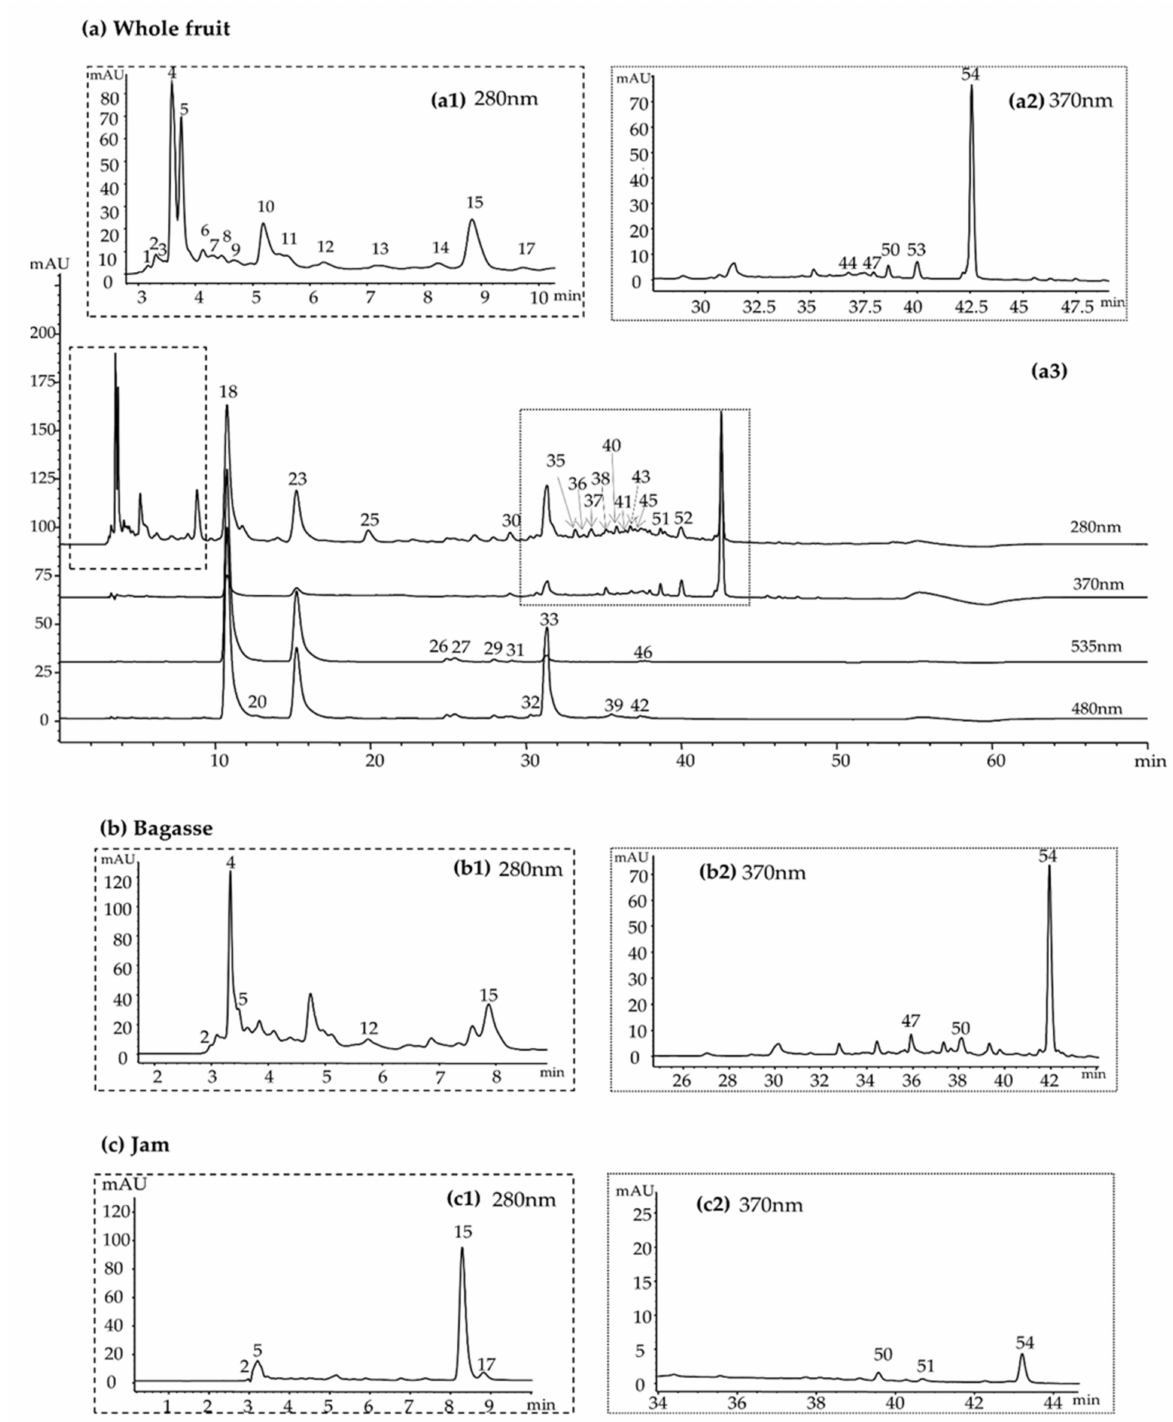
Figure 3. HPLC-DAD chromatogram of betalains and phenolic compounds in Opuntia stricta var. Dillenii from ( a ) whole fruit at 280 nm (zoom chromatogram 0–10 min, a1 ), 370 nm (zoom chromatogram 25.5–50 min, a2 ), and all chromatograms with UV-vis detection: 280, 370, 480, and 535 nm ( a3 ), ( b ) by-product (bagasse) from the industrialization, chromatogram at 280 nm (zoom chromatogram 0–10 min, b1 ) and at 370 nm (zoom chromatogram 25.5–50 min, b2 ) ( c ) and Opuntia stricta var. Dillenii‘s jam chromatograms at 280 nm (zoom chromatogram 0–10 min, c1 ) and at 370 nm (zoom chromatogram 25.5–50 min, c2 ). Numbers correspond to the identified compounds indicated in Table